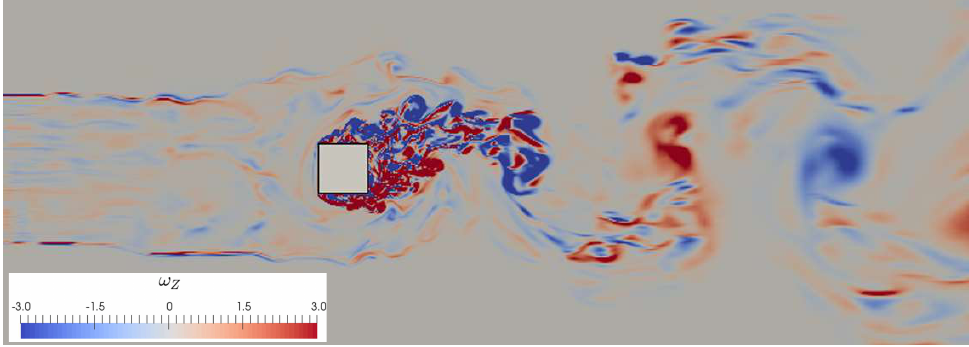
Figure 2. Contours of instantaneous spanwise vorticity over a stationary cylinder. ILS = 1.0 D , TI =